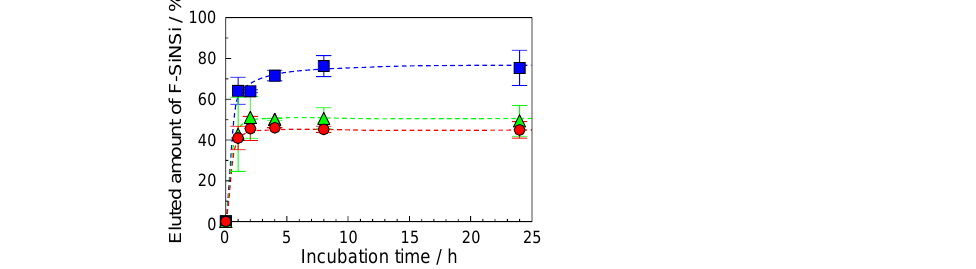
Figure 2. Water stability of F-SiNSi composite film: F-5 wt% SiNSi (closed squares), F-10 wt% SiNSi (closed triangles), and F-20 wt% SiNSi (closed circles) composite film. Each of the values represents the mean of three separate determinations ± standard deviations.